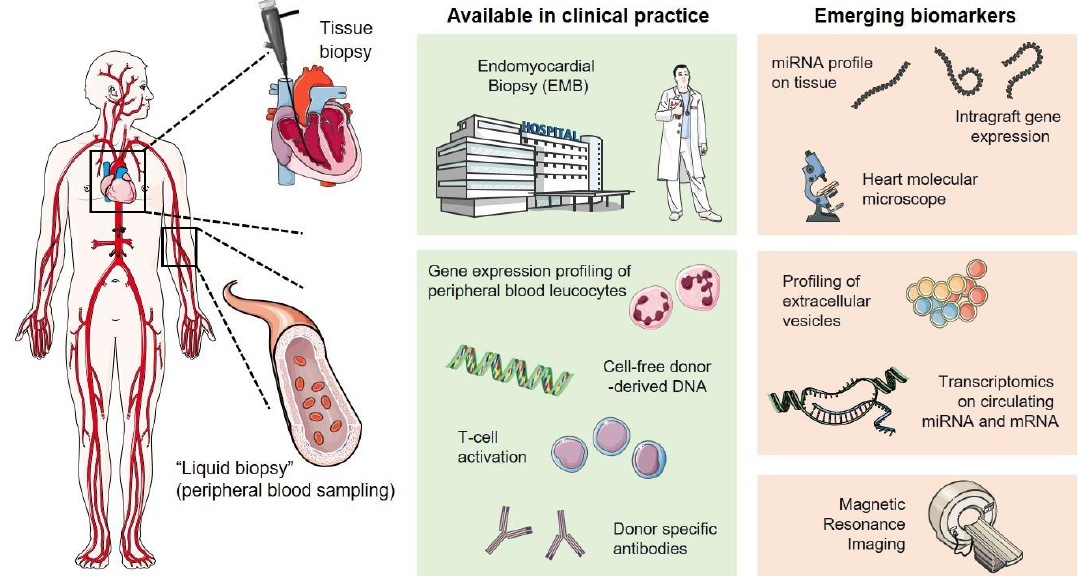
Figure 1. Overview of invasive and non-invasive approaches in cardiac allograft rejection